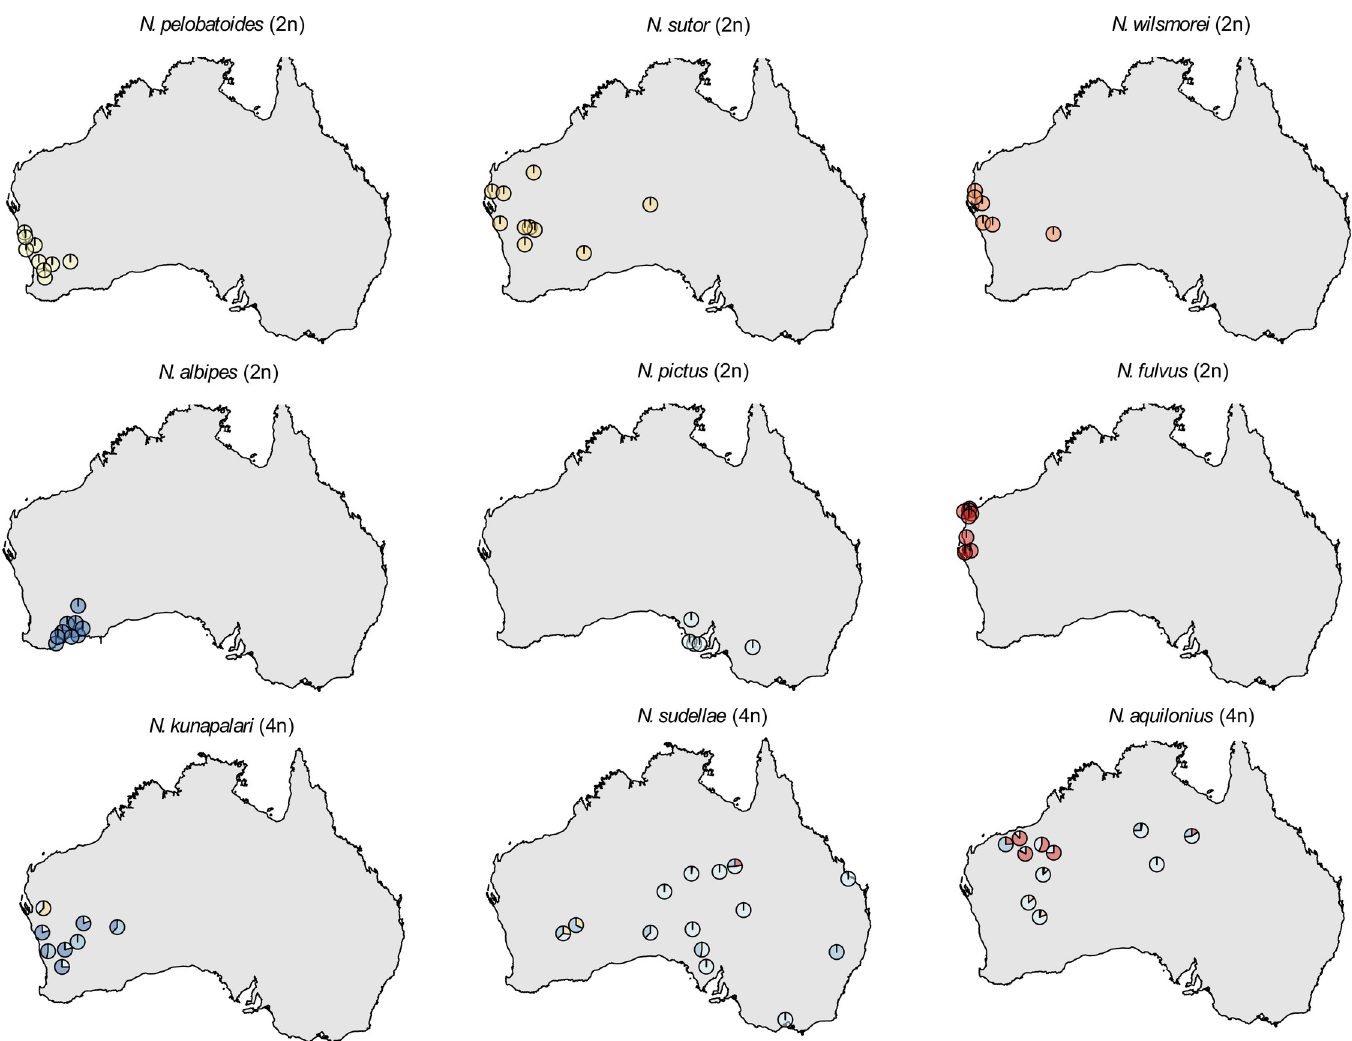
Fig 2. ADMIXTURE results (K = 7) shown separately for each species. According to the geographical locations of the sampled individuals, pie charts show the probability of the assignment of the individual to one of the 7 individually colored clusters. Overlapping pie charts on the map have been moved just enough to appear separate. Diploid Neobatrachus species (top 6: N . pelobatoides , N . albipes , N . wilsmorei , N . sutor , N . pictus , N . fulvus ) are each assigned to separate clusters, while all three tetraploid species (bottom 3: N . kunapalari , N . sudellae , N . aquilonius ) show inter-species